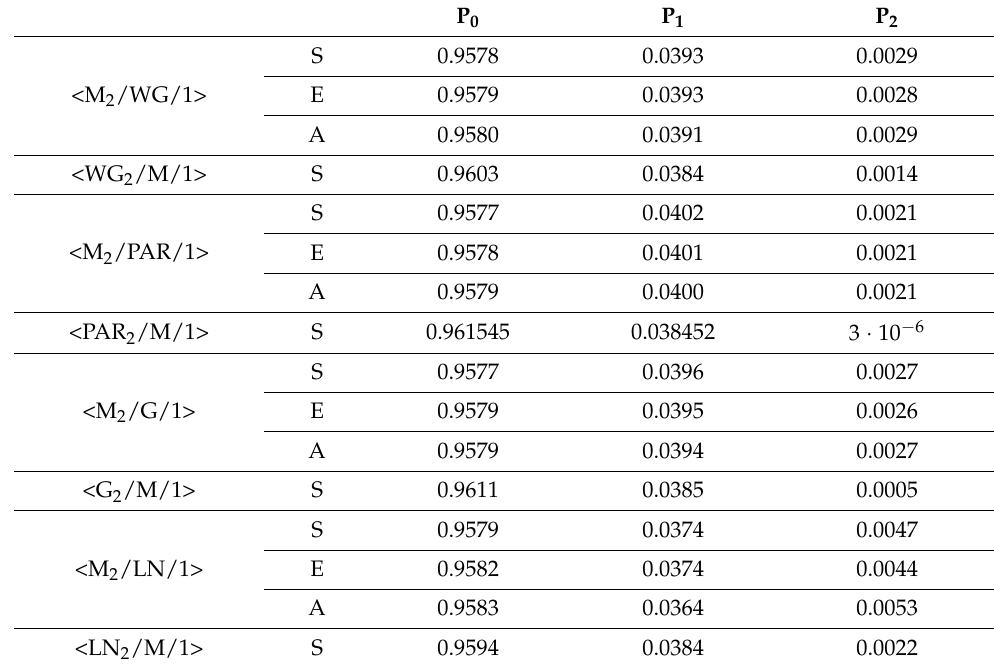
Table 1. Simulation (S), exact (E) and approximate (A) values of the steady-state probabilities p i of the system states with np = 2.